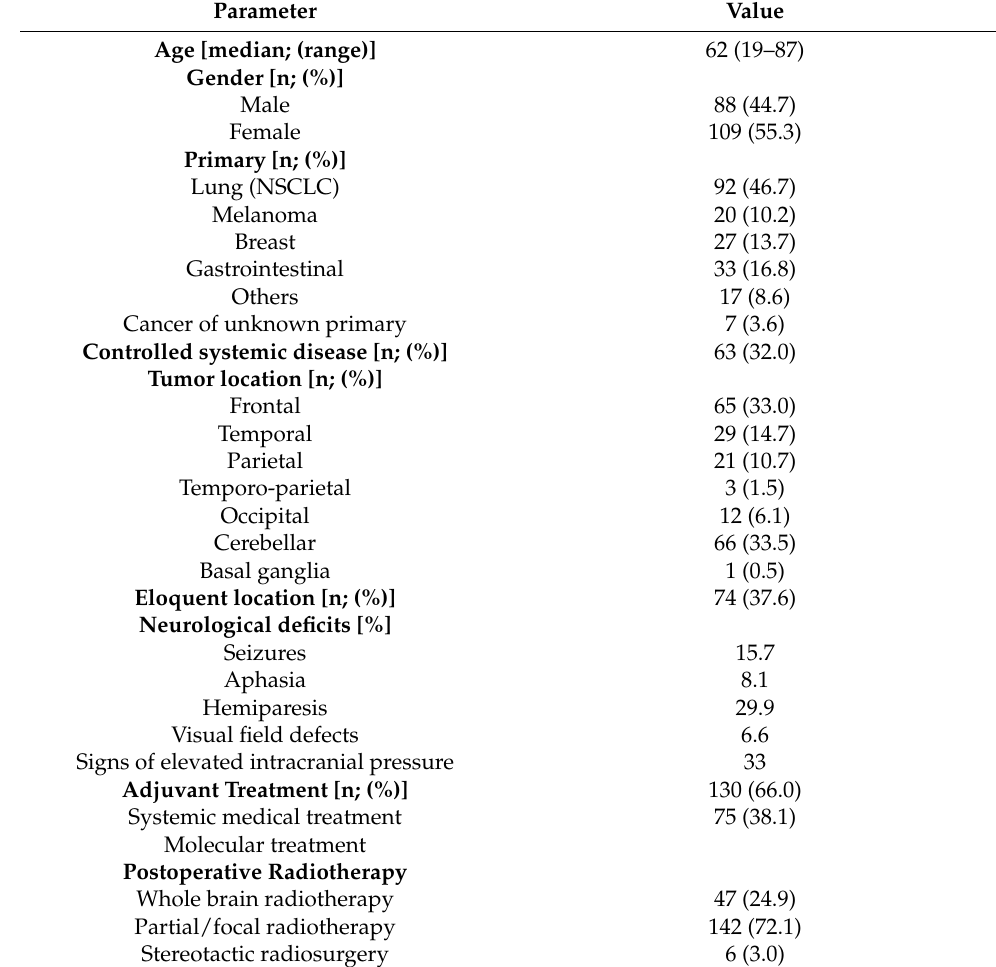
Table 1. Patient demographics, baseline characteristics, and location of